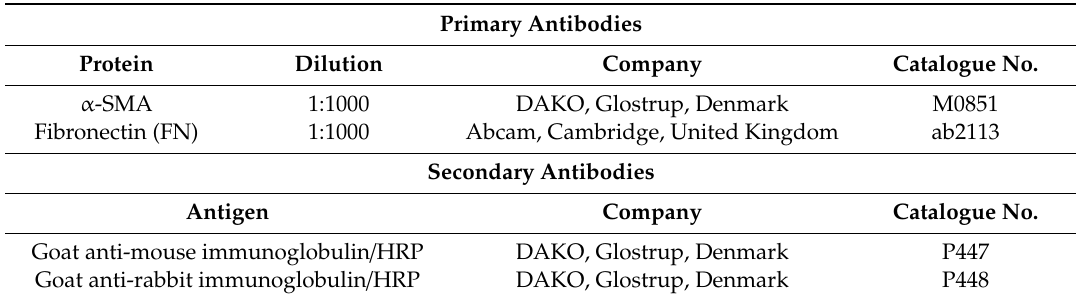
Table 1. Primary and secondary antibodies for western